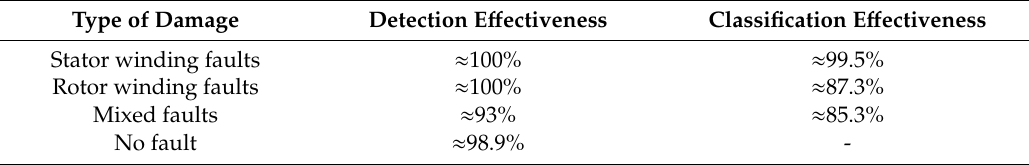
Table 2. E ff ectiveness of the IM winding fault detection and classification using MLP.